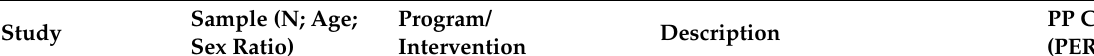
Table 1. Overview of the positive psychology intervention